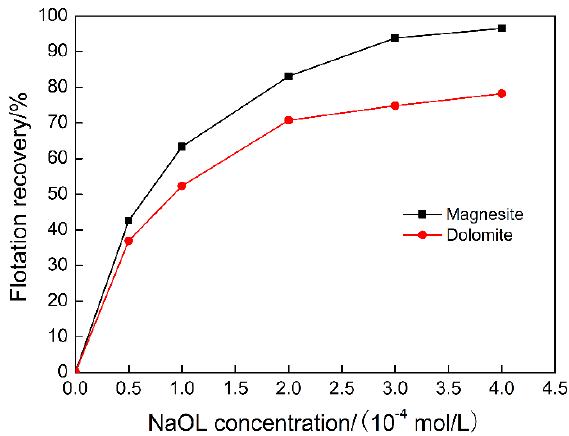
Figure 3. The effect of the concentration of collector on the flotation separation of magnesite and dolomite.